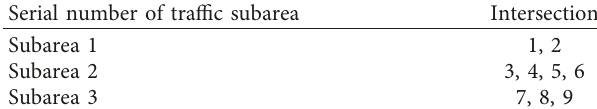
Table 1: The initial result of traffic subarea division.